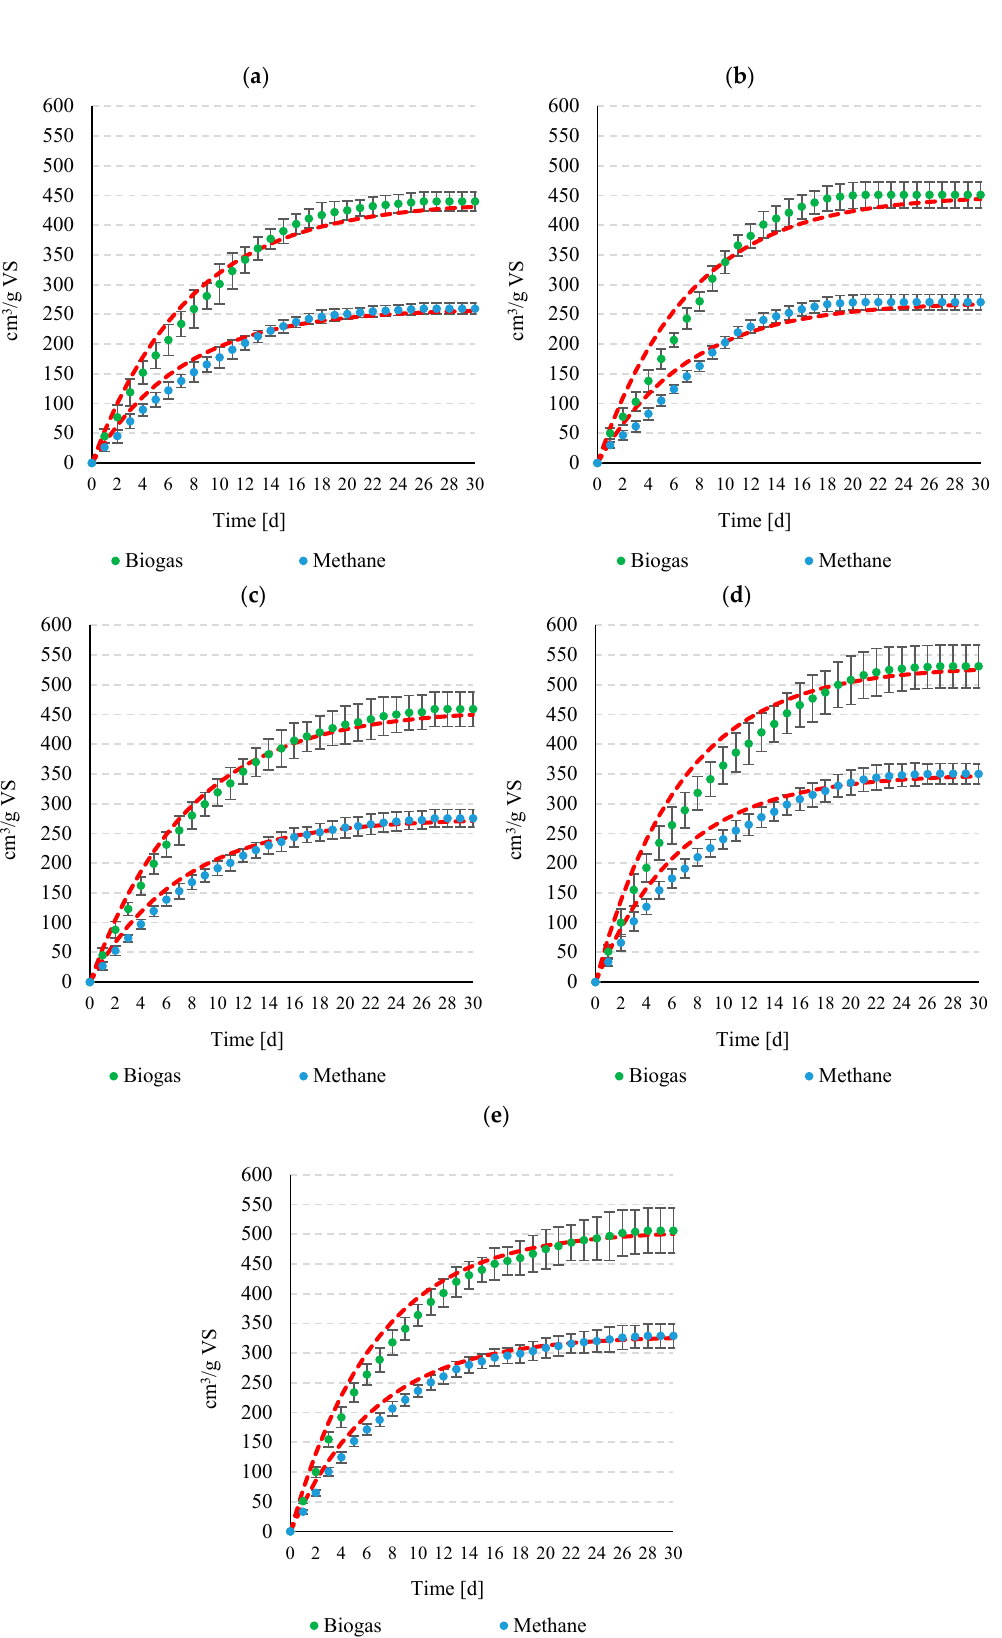
Figure 15. Trends in biogas and methane production in the anaerobic respirometers: ( a ) pure Chlorella sp. Culture; ( b ) biomass after 15 days’ PBR operation; ( c ) biomass after 30 days’ PBR operation; ( d ) biomass after 45 days’ PBR operation; and ( e ) biomass after 60 days’ PBR operation. The M-BGS produced after 30 days of experiment was similar in terms of anaerobic digestibility. There were no statistically significant differences in gas output from ferment- ative bacteria. Biomass production was 459 ± 29 cm 3 /gVS, containing 60.7 ± 3.1% CH 4 (Ta- ble 6). CH 4 output from the biomass in phases 1 (14 d) and 2 (30 d) of PBR operation was similar, at 271 ± 13 cm 3 CH 4 /gVS and 275 ± 15 cm 3 CH 4 /gVS, respectively (Figure 15). Table 6. Indicators of hydrophyte biomass AD performance. Indicator